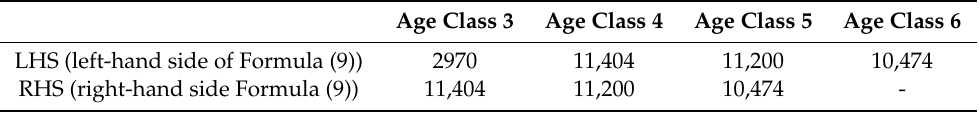
Table 4. Profits generated from harvesting by age class: forest started in bare land.